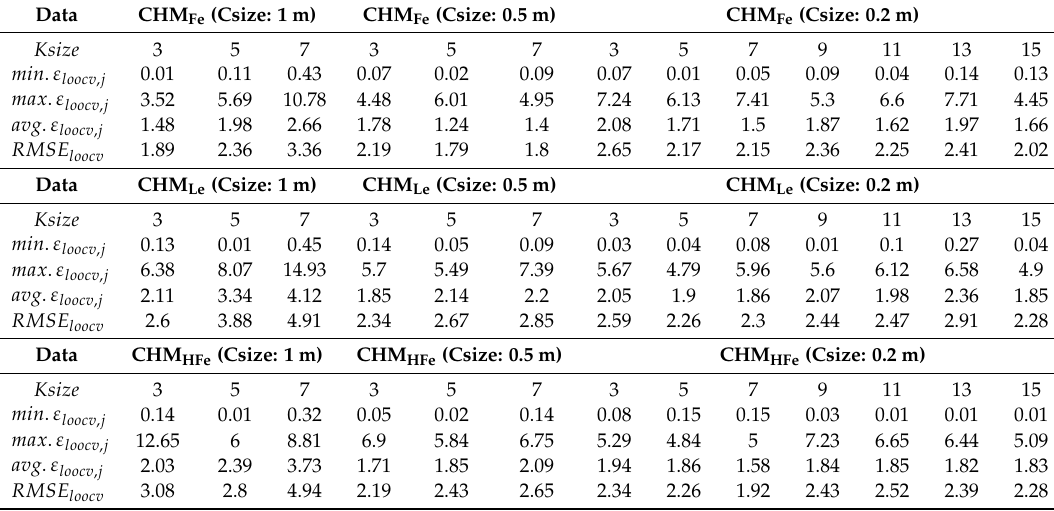
Table 2. The test data errors ( ε loocv , j ) and RMSE loocv obtained when using the LOOCV method.